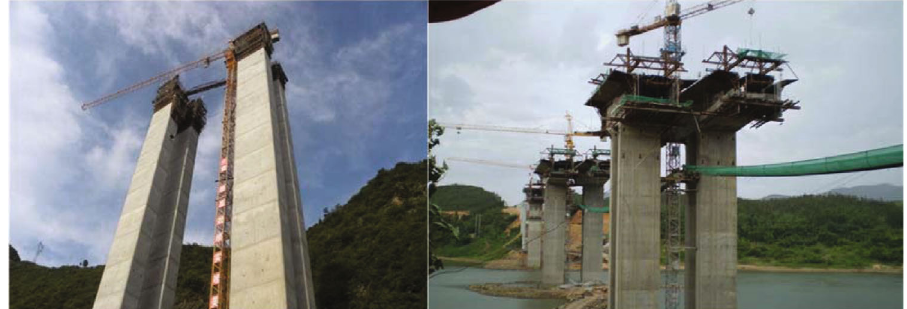
Figure 3: Double-limb thin-walled pier under construction in the river-crossing project.